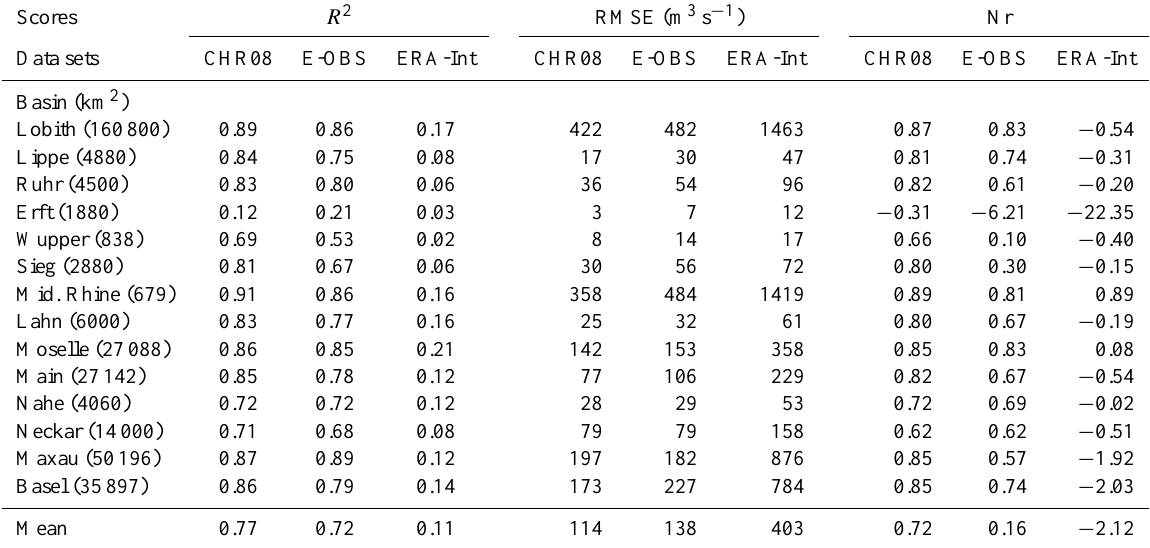
Table 1. Statistics of daily discharges for the period of 1990–2008, for 14 sub-catchments of the Rhine. Locations are roughly ordered from Lobith to the upstream catchment of Basel. Shown are square correlation coefficient ( R 2 ), Root Mean Square Error (RMSE) and Nash-Sutcliffe modeling efficiency